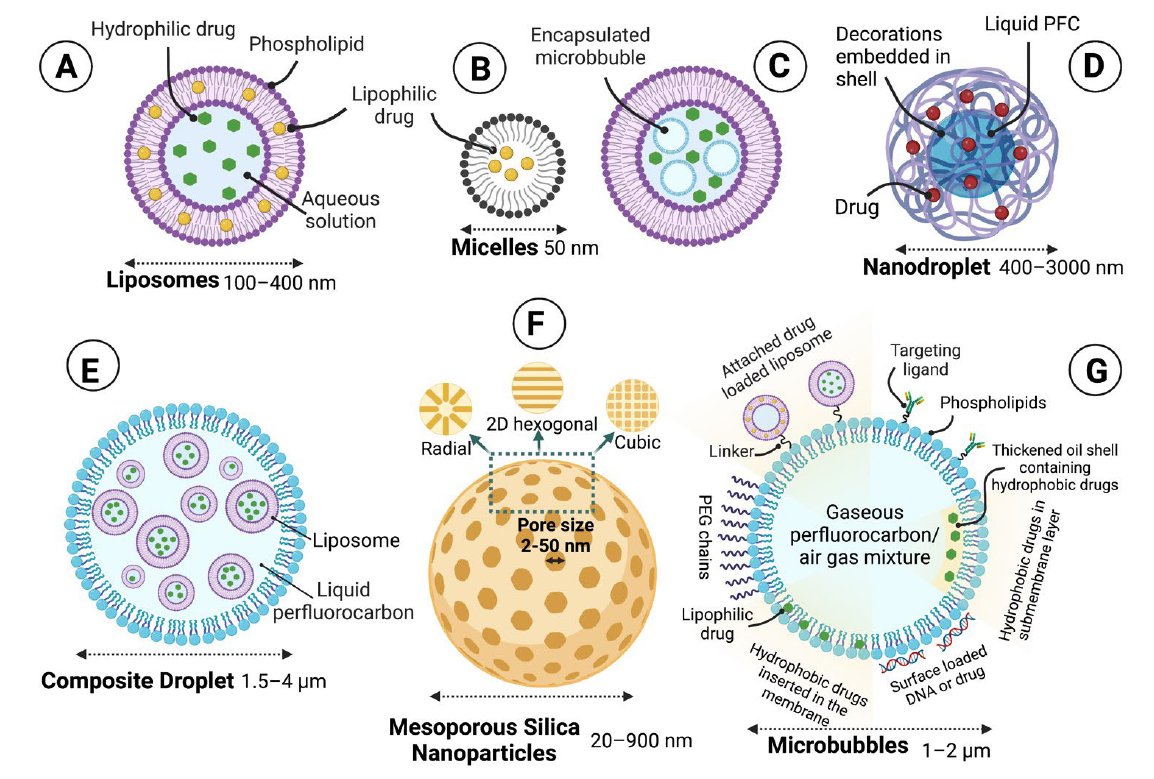
Figure 6. Schematic representation of various ultrasound-sensitive carriers. Liposomes ( A ) can deliver hydrophobic or hydrophilic drugs after ultrasound exposure. Micelles ( B ) can carry hydrophobic drugs within their core and have a higher release profile in response to ultrasound. ( C ) The MB can be encapsulated within a liposome along with the drug. When exposed to ultrasound, the MB ruptures the outer liposome, releasing the payload. Nanodroplets ( D ) can absorb acoustic energy, which causes the liquid perfluorobutane core to phase-change into a gas microbubble, thereby leading to drug release through the development of mechanical forces to the cellular membrane. Composite-droplets ( E ) are multiple emulsions (water or oil-in perfluorocarbon-in water) that can be converted with an imaging scanner and can transport large payloads. Mesoporous silica nanoparticles ( F ) are silica nanoparticles with variable pore structures such as radial, hexagonal, and cubic for controlled release. The grafted ultrasound-responsive polymers on the surface, acting like a nano valve, can control the release of loaded therapeutic molecules from these nanoparticles. Finally, MBs ( G ) can be covalently linked to drug-filled liposomes, or nucleic acids can be adsorbed on the external surface of the MBs via electrostatic attractions. The membrane can be thickened with an oil layer, allowing hydrophobic drugs to be carried within it or incorporated into the lipid monolayer shell of the MB. Additionally, targeting ligands such as antibodies can be conjugated to the surface to help facilitate the accumulation of MBs in desired tissues (Created with BioRender.com).